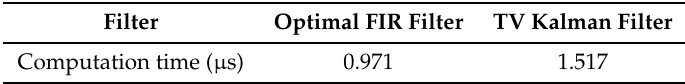
Table 2. The comparison of the average computation time.